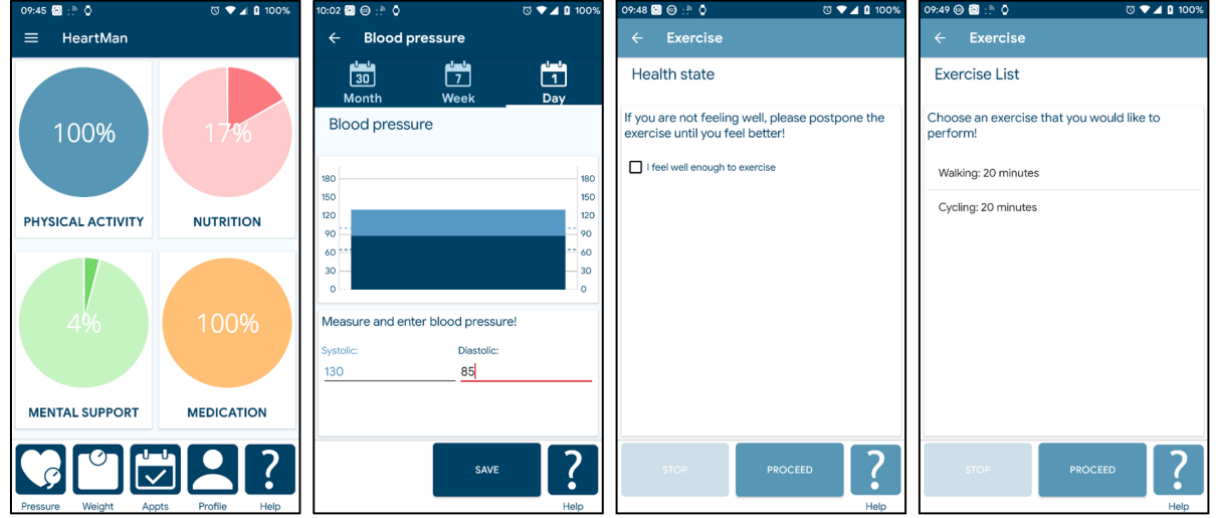
Figure 2. Exercise-related screens of the HeartMan app: the main screen, blood pressure input before the exercise, health check before the exercise, and exercise